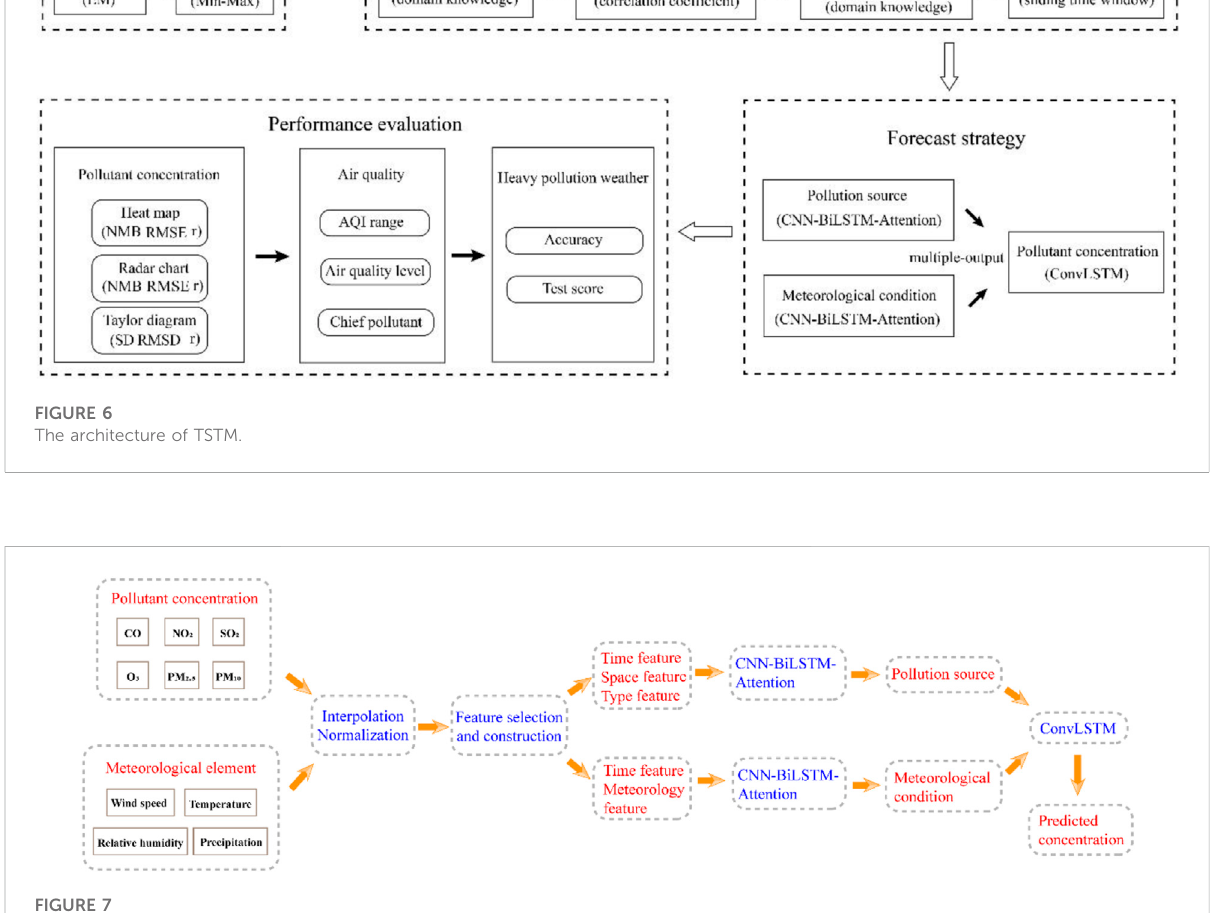
FIGURE 7 The work fl ow of